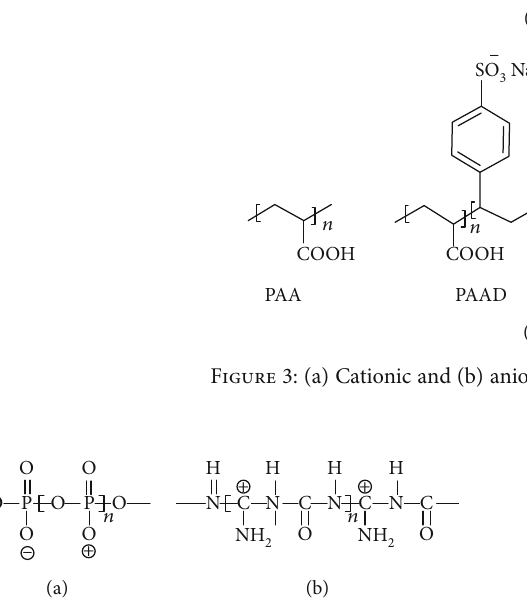
Figure 4: The molecular structure of the (a) polyphosphate derivative of guanidine and (b) urea copolymer (PGUC).